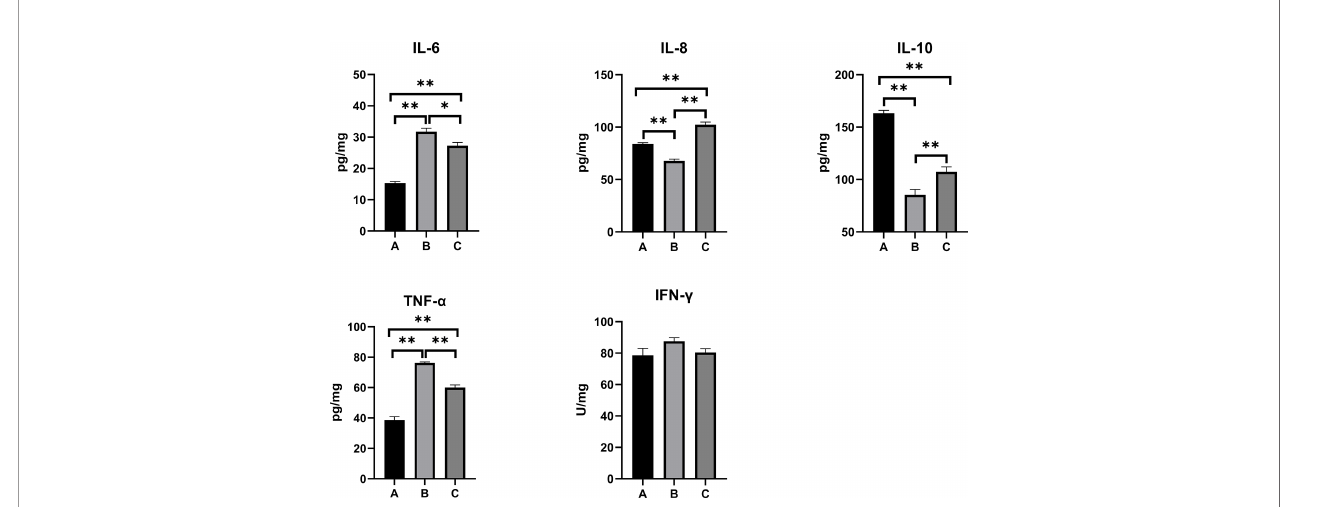
FIGURE 7 | Effects of OTA and AFB1 on liver cytokines (IL-6, IL-8, IL-10, TNF- a , and IFN- g ) of pullets after 42 days (n = 6, mean ± SEM). Groups A, B, and C are the control group, the pair-feeding group, and the OTA+AFB1 group, respectively. Data were analyzed with ANOVA and Tukey ’ s HSD, and signi fi cant differences were de fi ned as * p < 0.05 and ** p < 0.01. OTA, ochratoxin A; AFB1, a fl atoxin B1; HSD, honestly signi fi cant difference.